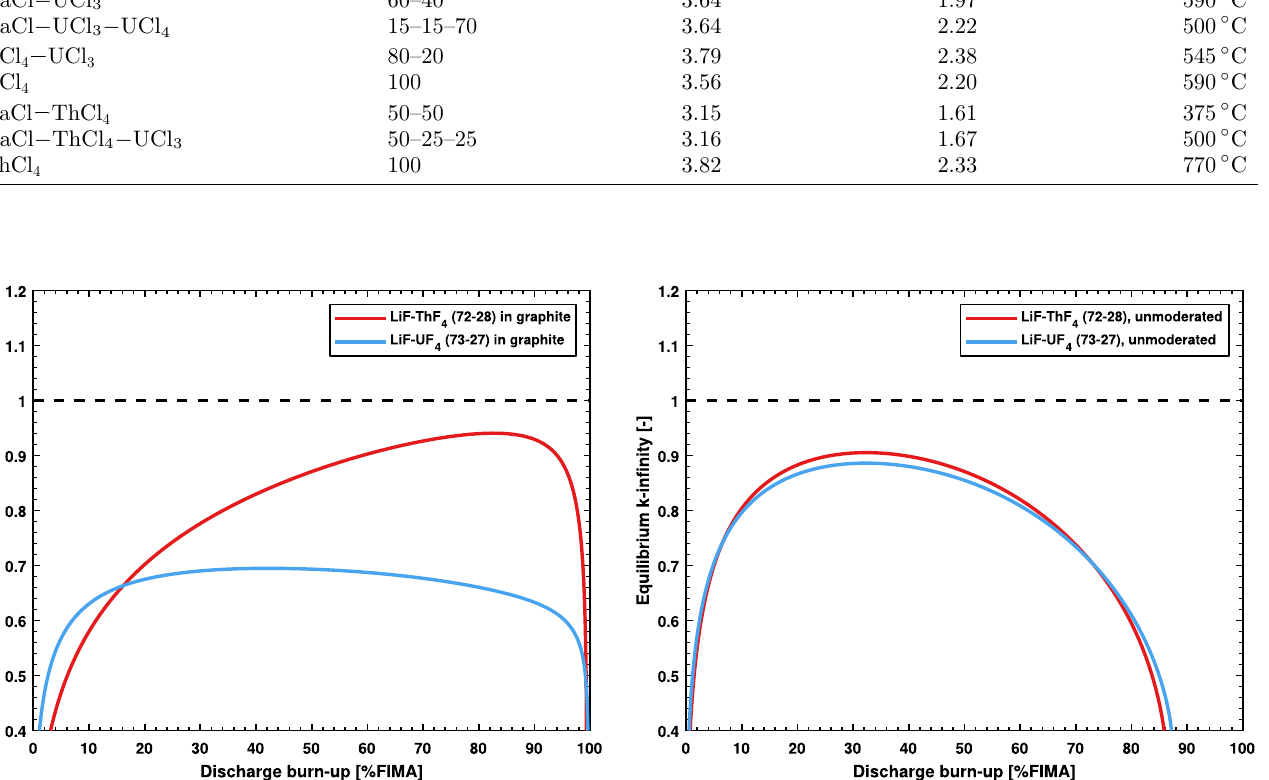
Fig. 5. Achievable equilibrium k ∞ as function of the discharge burn-up for fluoride salts in a graphite-moderated lattice.